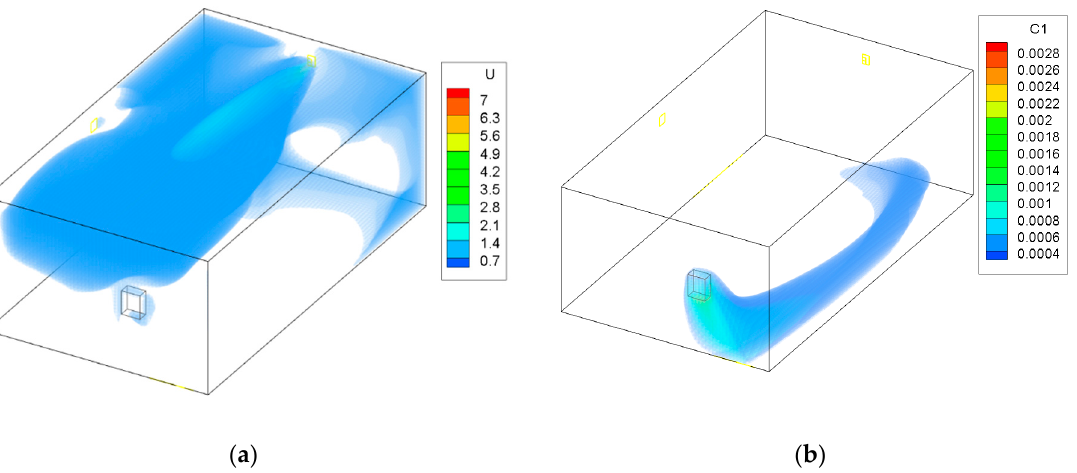
Figure 5. Case 4—minimum flow and minimum area of the ATD; ( a ) air velocity (m/s), ( b ) CO contraction (kg/kg).